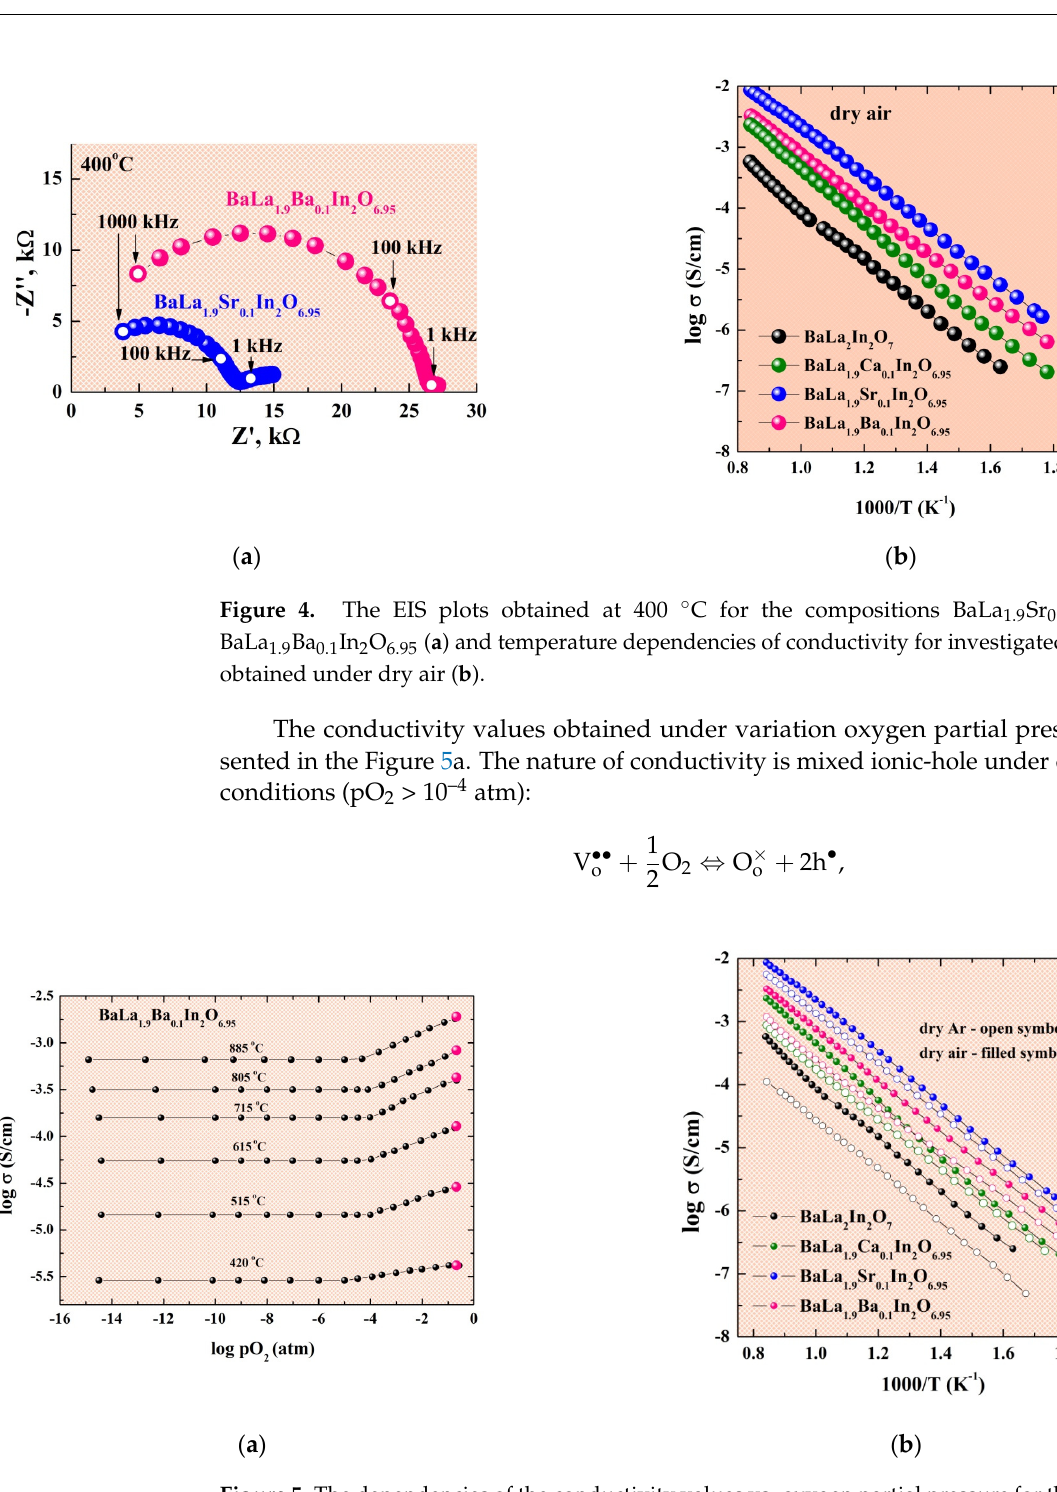
Figure 5. The dependencies of the conductivity values vs. oxygen partial pressure for the composition BaLa 1.9 Ba 0.1 In 2 O 6.95 and conductivity values from σ –1000/T dependencies under dry air (filled pink symbols) and dry Ar (open pink symbols) conditions ( a ) and temperature dependencies of conductivity for investigated compositions obtained under dry air and dry Ar ( b